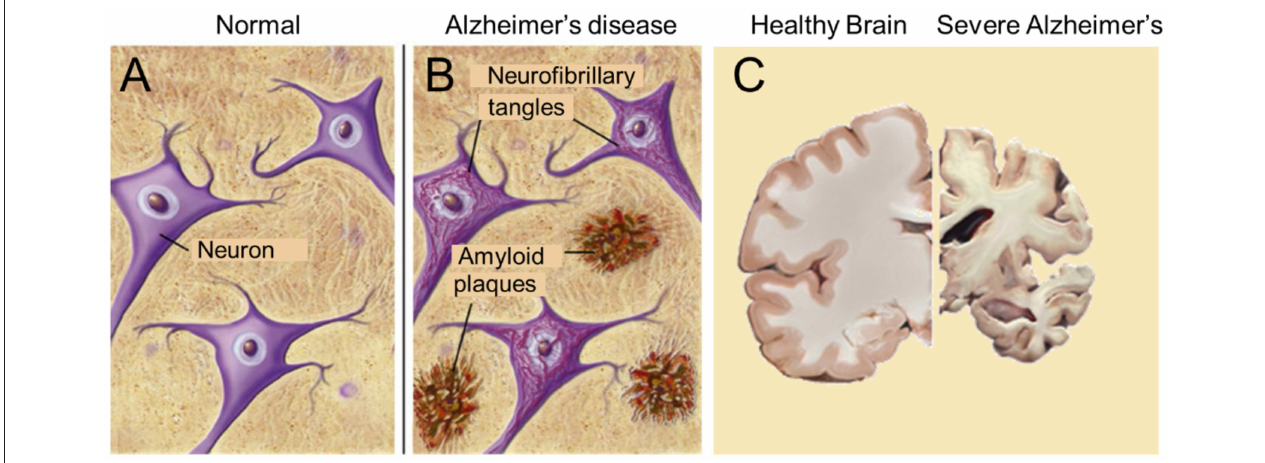
FIGURE 6 | The major pathological hallmarks of the disease are amyloid plaques and neurofibrillary tangles (B) , which are absent in healthy brain tissue (A) . Massive apoptosis occurs in later stages of Alzheimer’s disease in the human brain (brain slices) (C) . Sources: (A,B) from Google Images, BrightFocus Foundation (Alzheimer’s disease: Amyloid Plaques and Neurofibrillary tangles). (C) Wikimedia, from Elsevier Sci. Tech connect. The neural basis of Alzheimer disease. Posted by Caitlin Beddows, 2016. All figures are Open